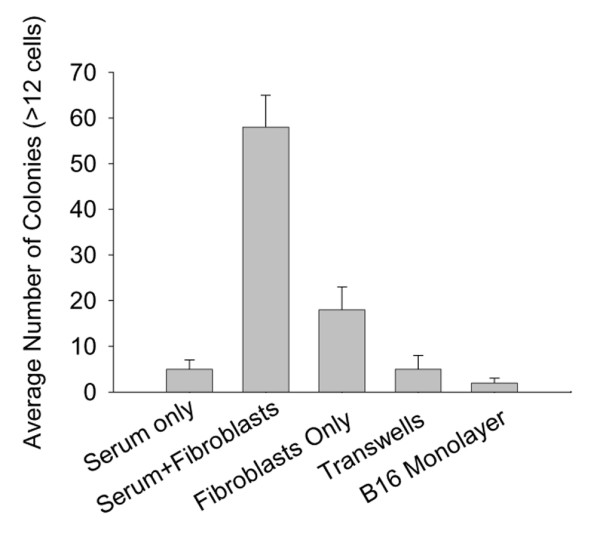
Results of the co-culture assay. Each bar represents the mean and standard deviation of triplicate measurements. Tumor cells seeded on a monolayer of serum-activated fibroblasts produced the highest average number of colonies. There were significantly fewer colonies if fibroblasts or serum were omitted. Co-culture with fibroblasts separated by permeable transwell inserts or on a monolayer of B16 cells yielded low numbers of colonies that were statistically indistinguishable from the control using tumor cells grown in serum-supplemented medium without fibroblasts.